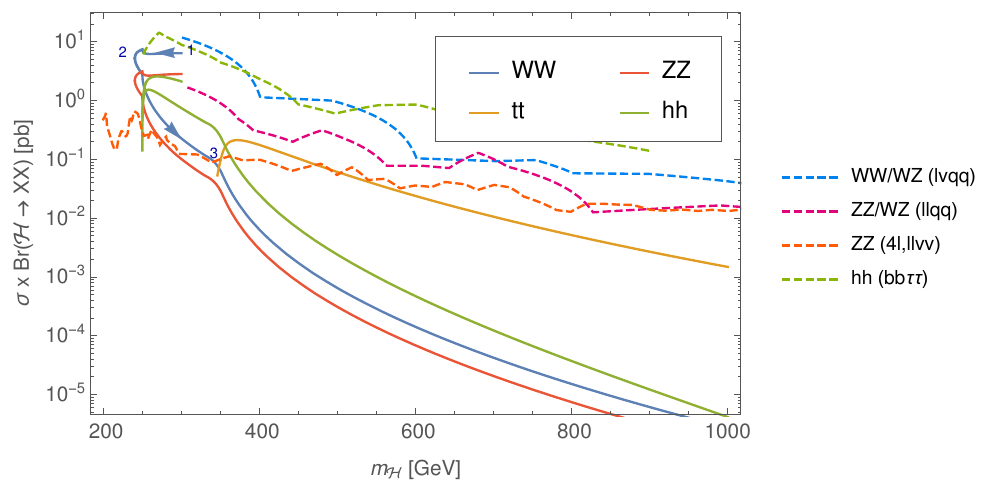
Figure 7 . (cid:27) (cid:2) Br( H ! XX ) for the benchmark scenario with (cid:12)xed s (cid:18) = 0 : 1 and m 2 arrow shows the growing t (cid:12) , and the points 1, 2, and 3 represent t (cid:12) = 1 ; 1 : 7 ; 3 : 6, resp. The LHC limits are shown in dashed